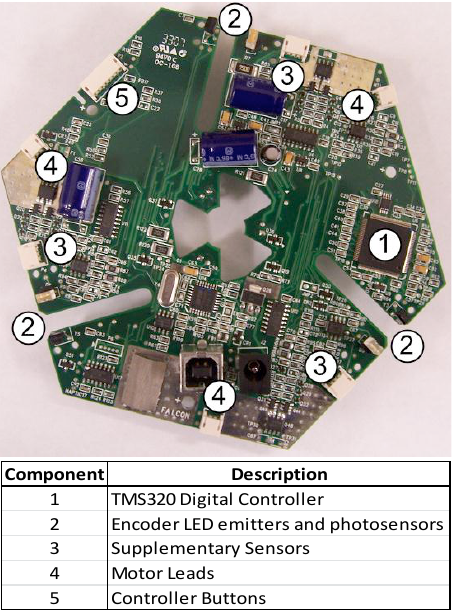
Table 2: Description of components in Figure 8 Figure 11. The embedded circuit board in the Novint Falcon, and a description of its